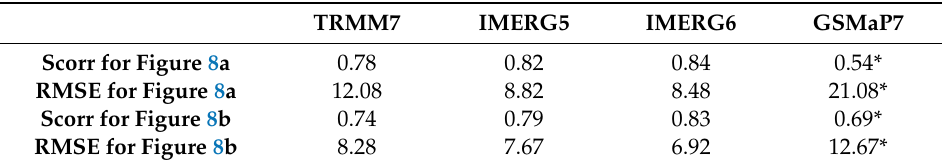
Table 3. Statistical values for the comparison between the CWB data and SPPs shown in Figure 8. The unit of RMSE is %. The lowest value of Scorr and the highest value of RMSE are marked by *. The sample size is 392 grid points.